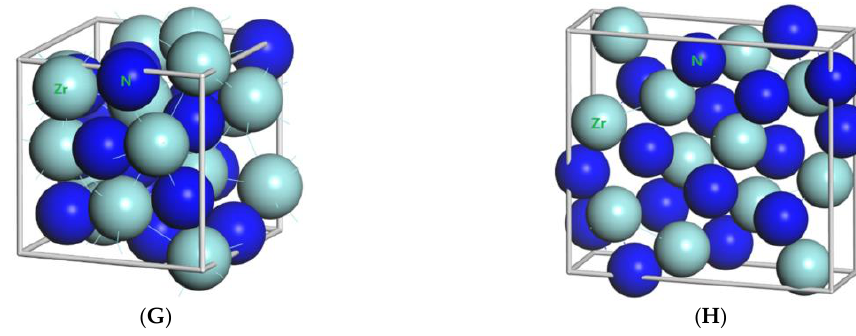
Figure 1. Primitive unit cells of ( A ) TiN with space group of Fm3m; ( B ) Ti 2 N with space group of P4 2 /mnm; ( C ) Ti 2 N with space group of I4 1 /amdz; ( D ) ZrN with space group of P6 3 mc; ( E ) ZrN with space group of Fm3m; ( F ) Zr 3 N 4 with space group of Pna2 1 ; ( G ) Zr 3 N 4 with space group of I43d; ( H ) Zr 3 N 4 with space group of Pnam. Table 1. Lattice parameters a , b , c , cell volume ( V ), the cutoff energy (eV) and K point of Ti 2 N, ZrN and Zr 3 N 4.